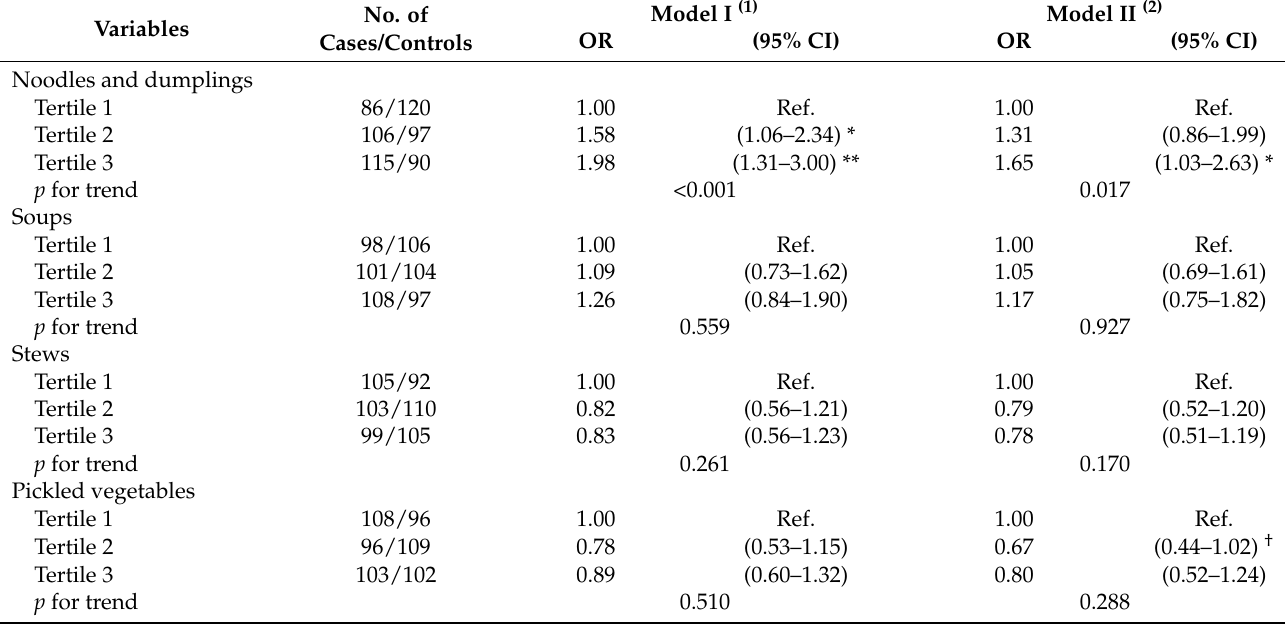
Table 3. Odds ratios of gastric cancer by high-sodium dish